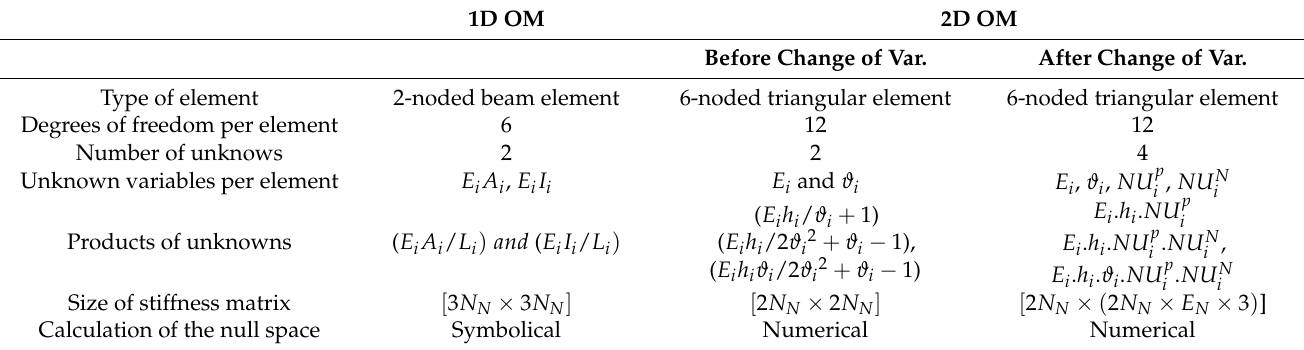
Table 3. Comparison of 1D and 2D observability methods